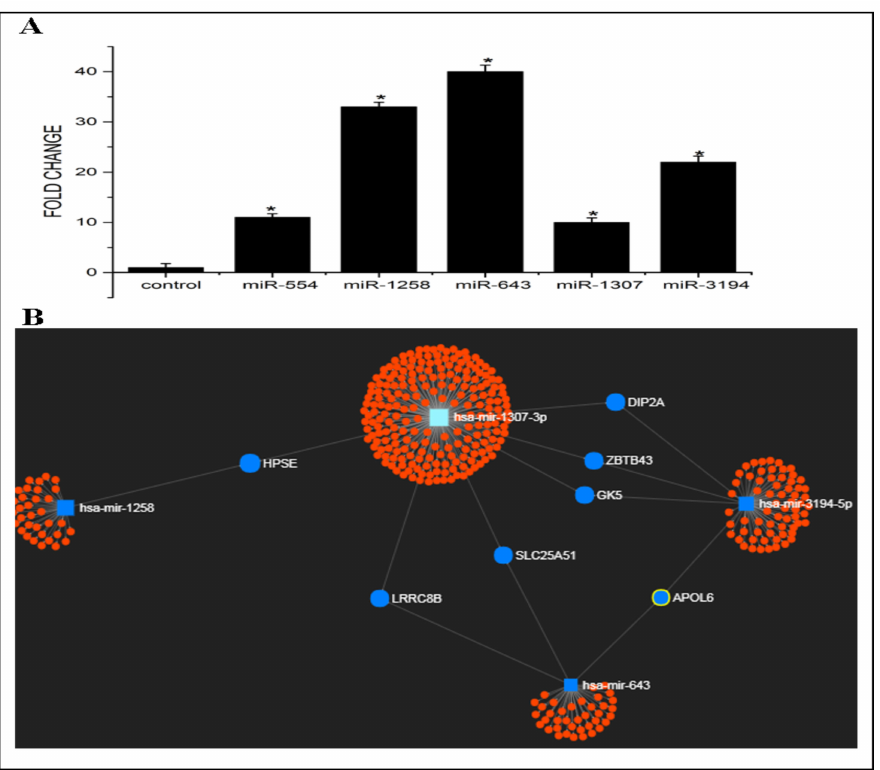
Figure 1. Expression levels and target prediction analysis of candidate miRNAs in exosomes secreted by Cp-r HepG2 cells (EXres). ( A ). Expression levels of candidate miRNAs in EXres. miRNAs were isolated from EXsen and EXres followed by cDNA synthesis and RT-PCR analysis of candidate miRNAs such as miR-554, miR-1258, miR-643, miR-1307, and miR-3194. The term fold change refers to the relative expression level of candidate miRNAs. Results presented are average of three experiments ± SEM each done at least in triplicate, p < 0.05. * Statistically significant when compared to control. ( B ). Target prediction analysis of candidate miRNAs. The hairball network represents candidate miRNAs targeting multiple genes. The centre part of the hairball structure represents the individual miRNA and edges represent their target genes. The genes that are commonly targeted by the candidate miRNAs are represented in blue